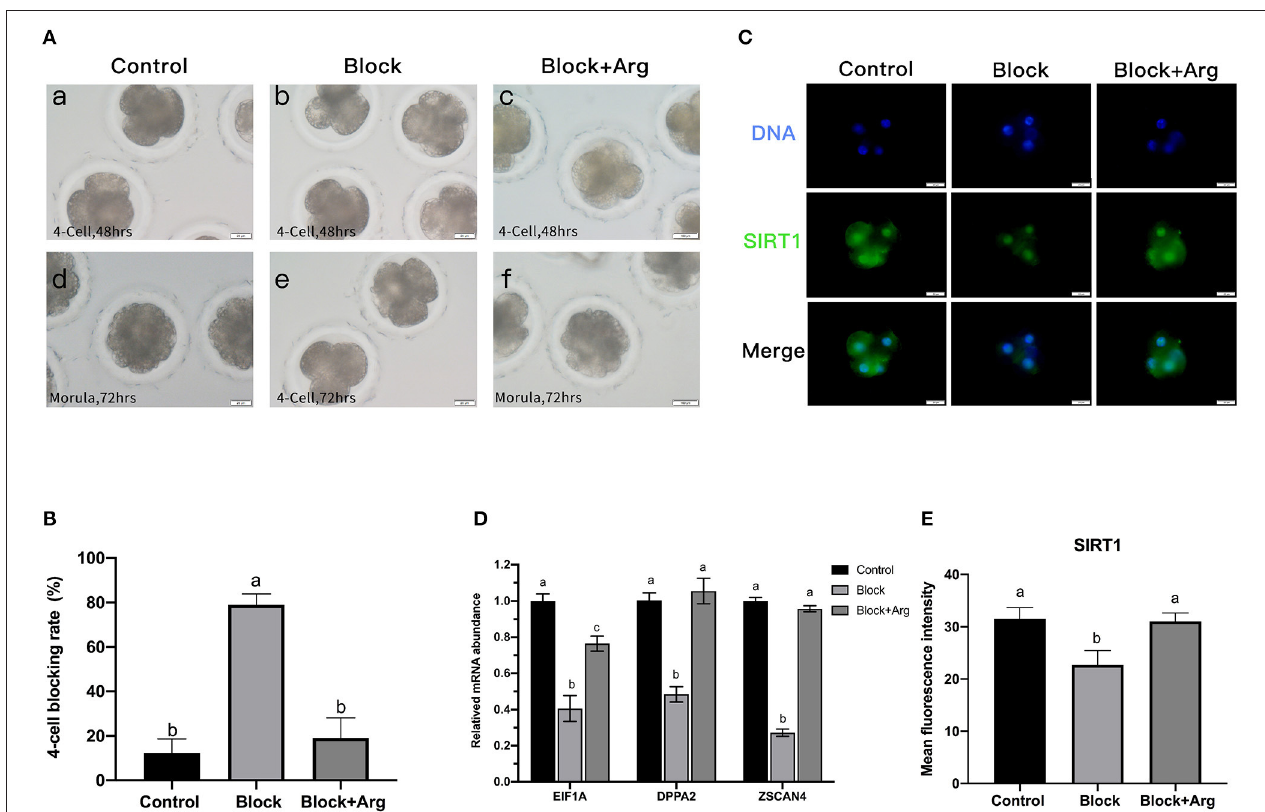
FIGURE 3 | Effects of arginine on the 4-cell block and ZGA under nutrition restriction. (A) Developmental status of embryos cultured in different media. Embryos cultured in PZM-3 medium as a Control group at (a) 48h (4-cell) and (d) 72h (morula). Embryos cultured in mPZM-3 medium as a Block group at (b) 48h (4-cell) and (e) 72h (4-cell block). Embryos cultured in mPZM-3 medium supplemented with arginine as the Block + Arg group at (c) 48h (4-cell) and (f) 72h (morula). (B) The 4-cell arrest rate at 72h in the Control, Block and Block + Arg groups. (C) Representative epifluorescence microscopic images of SIRT1 in the Control, Block, and Block + Arg groups. Bar = 50 µ m. (D) Expression of ZGA genes measured by qRT-PCR. EIF1A : eukaryotic translation initiation factor 1A; DPPA2 : developmental pluripotency associated gene 2; ZSCAN4 : zinc finger and SCAN domain containing 4. n = 3; different letters (a, b) indicate significant differences ( P = 0.05). (E) Results of the statistical analysis of embryonic SIRT1 intensity in the Control, Block, and Block + Arg groups. Control: n = 40; Block: n = 40; Block + Arg: n =